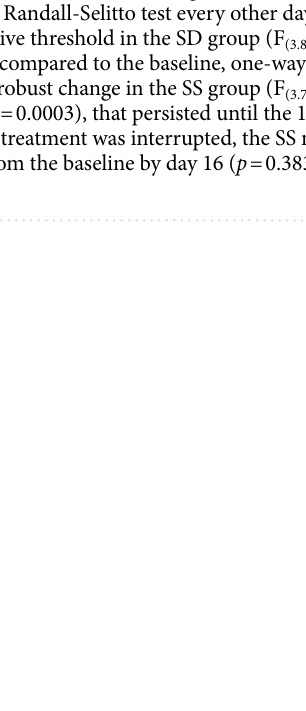
Figure 5. SS rats exhibit lower plasma diurnal corticosterone levels. To determine variations during the day in the levels of HPA activity, plasma corticosterone was measured in unstressed SS and BN rats at 8 am and 4 pm. Although corticosterone increased over the day in the BN group (t 4 = 5.171, ** p = 0.0066 when the 4 pm levels were compared to 8 am, paired Student’s t-test), in the SS, there was no significant variation (t 4 = 1.708, p = 0.1628, NS), indicating a flattened diurnal rhythm. n = 5 per